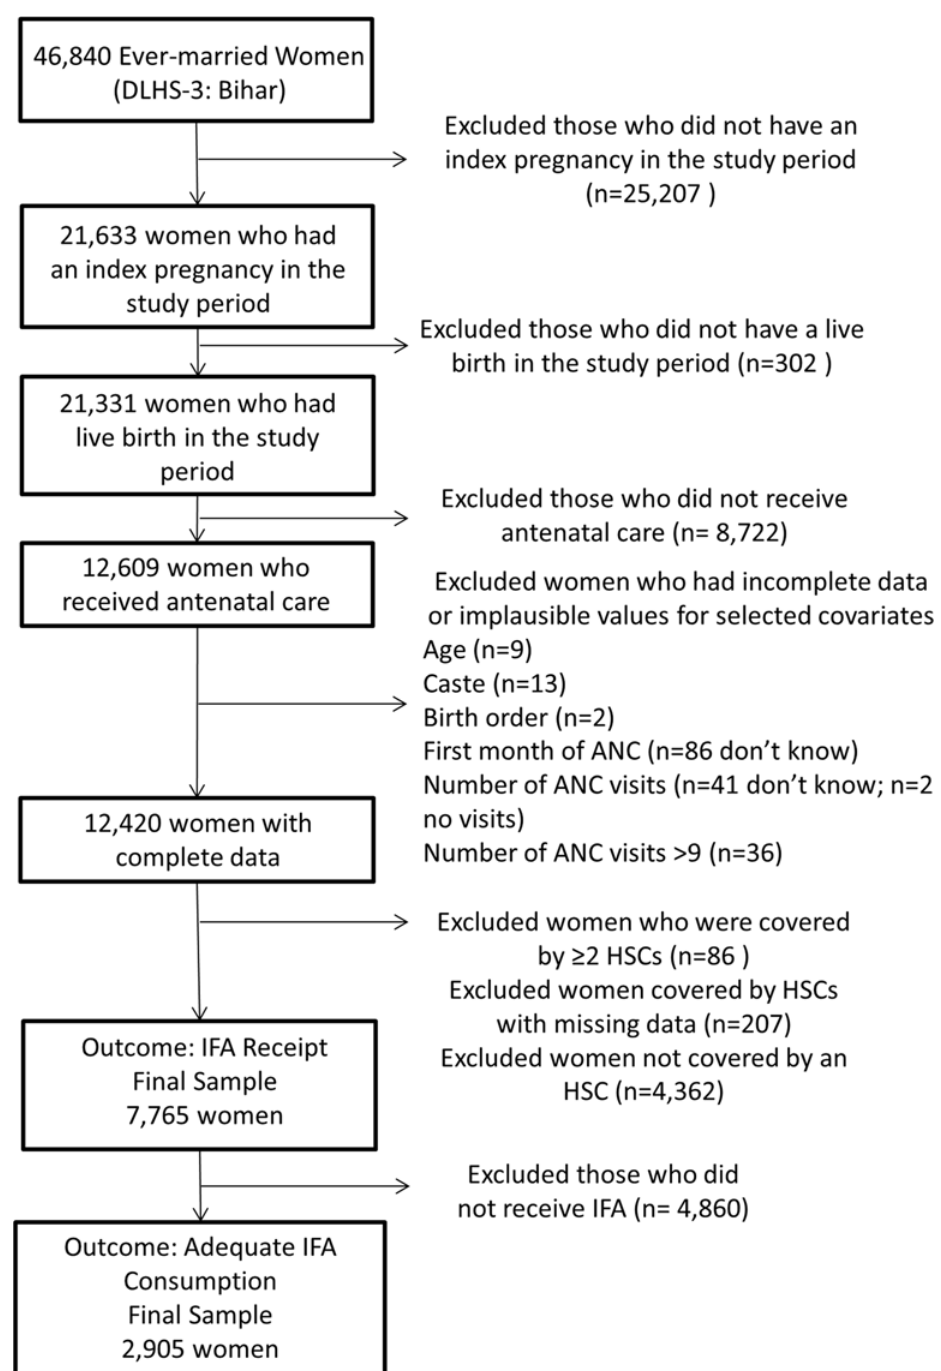
Fig 1. Flowchart of ever-married women exclusions and final sample. Flowchart of exclusions and final sample of ever-married women surveyed in Bihar through DLHS-3. DLHS: District Household Survey; ANC: Antenatal care; HSC: Health Sub-Center; IFA: iron and folic acid tablets or syrup.